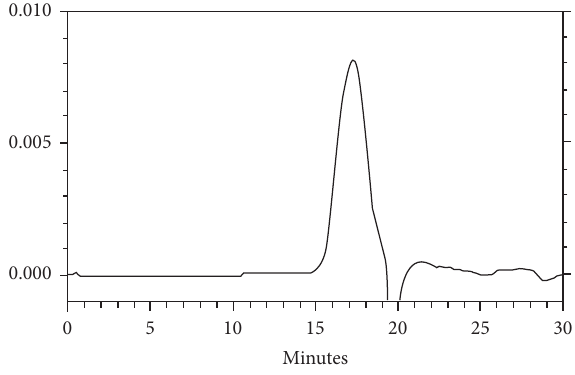
Figure 1: HPLC result of lentinan.